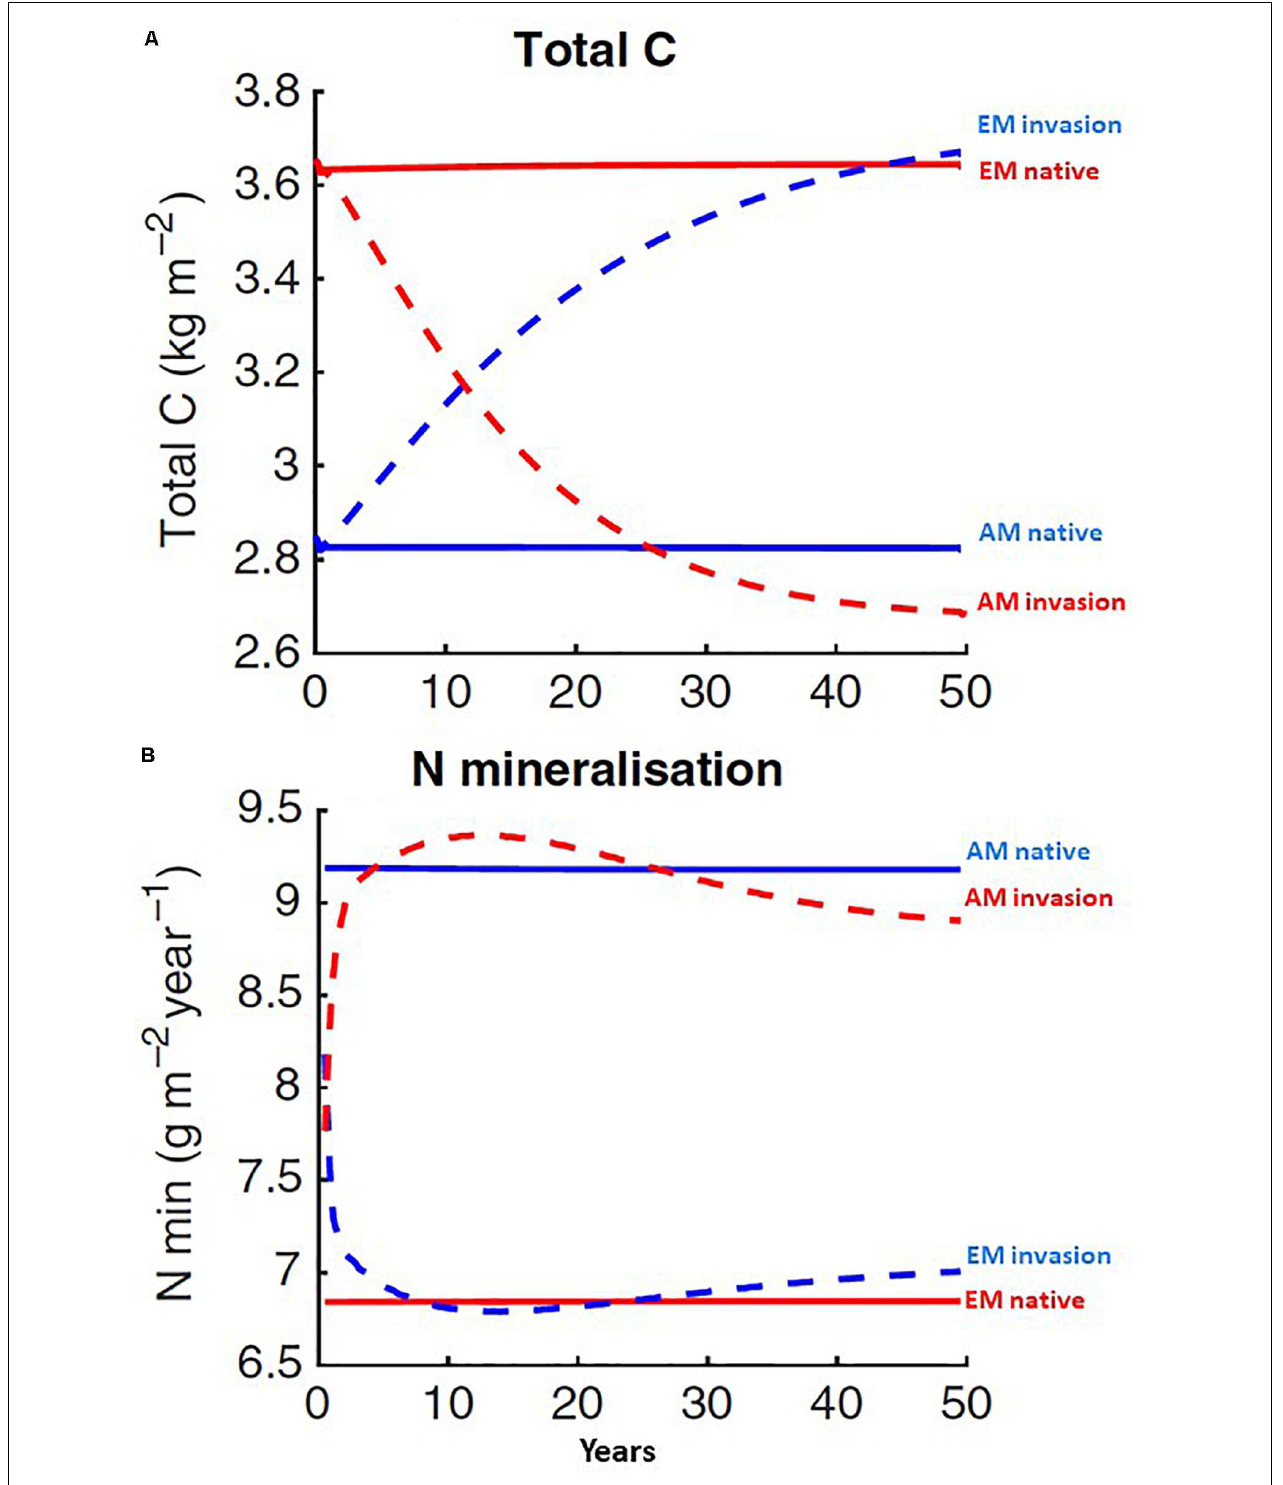
FIGURE 5 | FUN optimally allocates C to gain N through roots and symbionts and CORPSE predicts the impacts of the C on soil processes. EM or AM invasion leads to sustained shifts in the trajectories of (A) C and (B) N cycling over time. Figure created using data from Sulman et al. (2017).